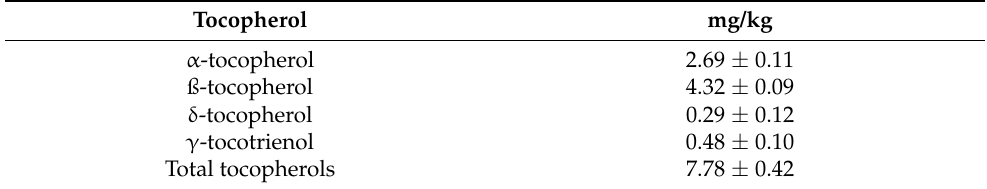
Table 5. Tocopherols (mg/kg) of dried destoned virgin olive pomace (DDVOP). The data represent the mean values of three replications with their relative standard deviation